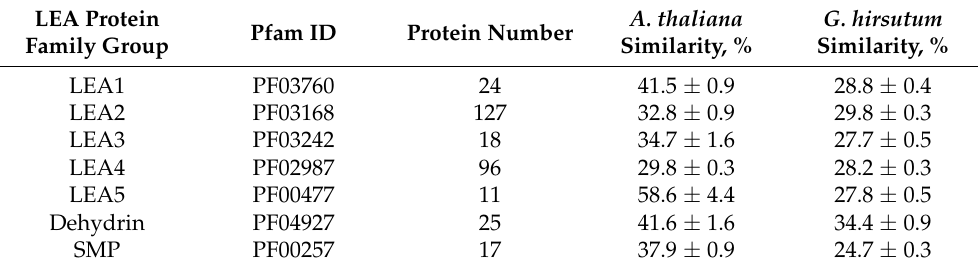
Table 1. Sequence similarity of R. serbica LEAPs with LEAPs from A. thaliana and upland cotton, G. hirsutum